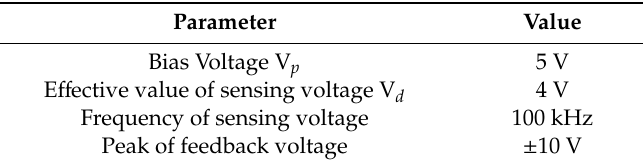
Table 3. Circuit parameter list.